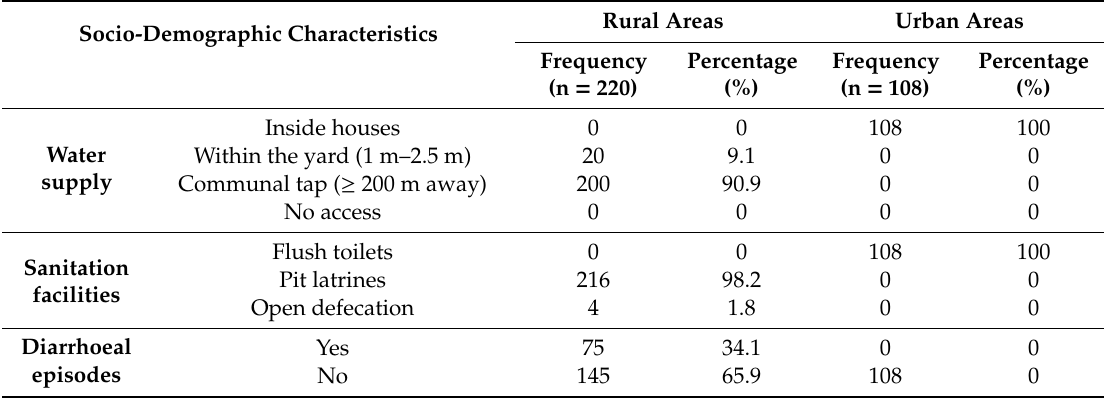
Table 2. An overview of water supply, sanitation facilities and episodes of diarrhoea in the target study areas.